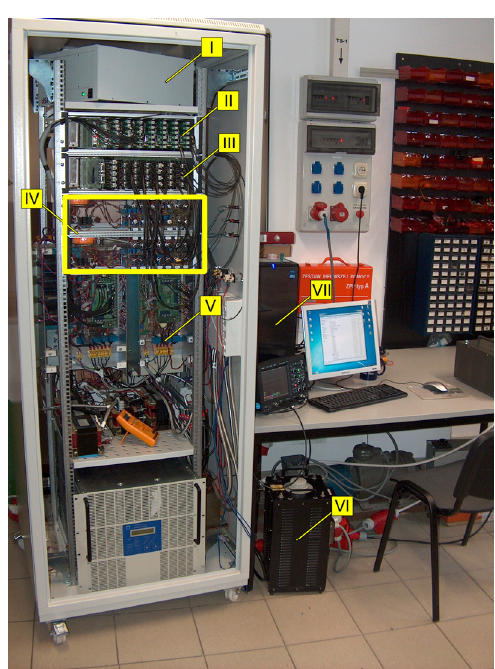
Fig. 8. Laboratory control setup: I – dSpace 1005 system, II – PWM control signal interface, III – signal conditioning, IV – LEM based measure circuits, V – AC/DC/AC converter, VI – autotransformer, VII – PC class